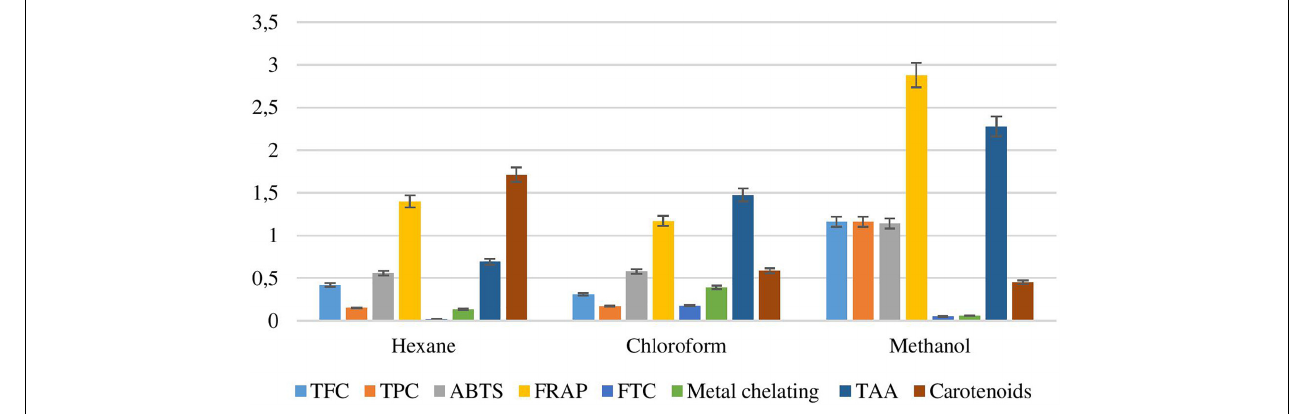
FIGURE 5 | Antioxidant activity of Padina antillarum (Kützing) Piccone.